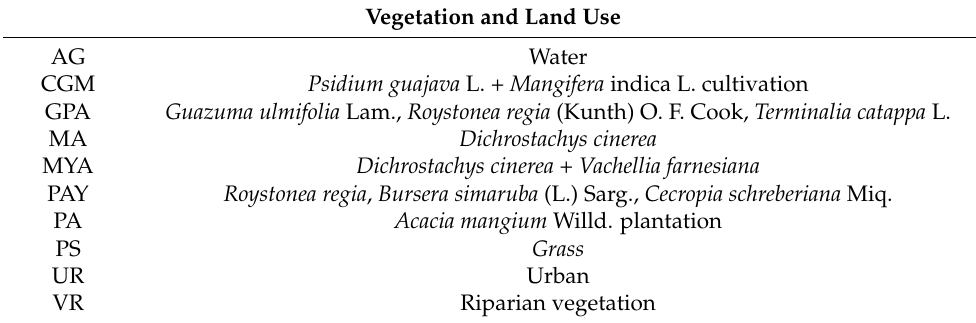
Table 2. Land-use and vegetation classification based on spectral signatures of a Landsat-8 image of Trinidad-Valle de los Ingenios,